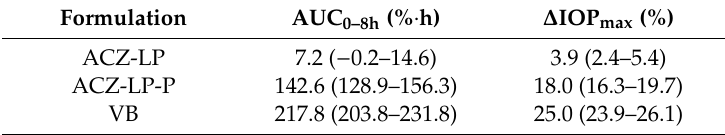
Figure 3. Stage two: ( a ) Intraocular pressure (IOP, %) mean after instillation of 25 µ L of ACZ-LP liposomal formulation (0.7 mg / mL acetazolamide and 20 mg / mL liposomes expressed in concentration of PC in vehicle base) and ACZ-LP-P (0.7 mg / mL acetazolamide, 20 mg / mL liposomes expressed in concentration of PC and 0.3% HPMC in vehicle base). ( b ) Area under curve of the ∆ IOP (%) versus time (h) from 0 to 8 h—AUC (0–8h) . ( c ) Maximal IOP reduction ( ∆ IOP max , %). The results are expressed as the mean ± standard error. Table 5. Stage two: mean values of area under the ∆ IOP-time curve and the ∆ IOP max of each treatment (90% confidence limits). For the purpose of comparison, the vehicle base data have been also included in Table